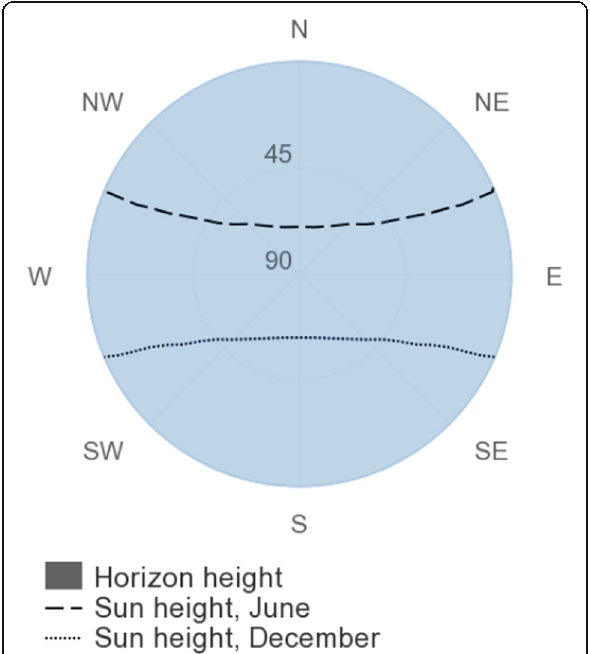
Fig. 4 Outline of the horizon in the site